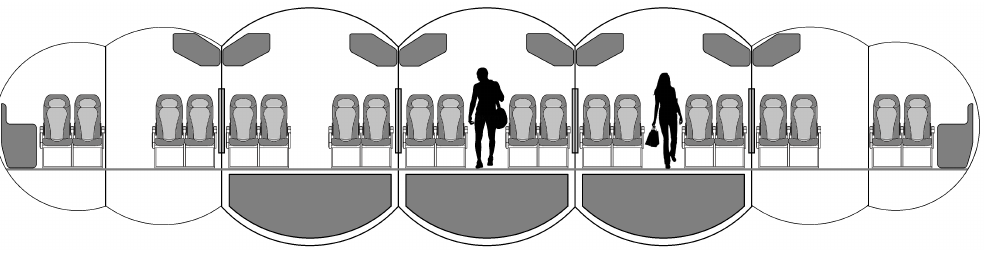
Figure 4. Cross-sectional cabin layout for the blended wing body.